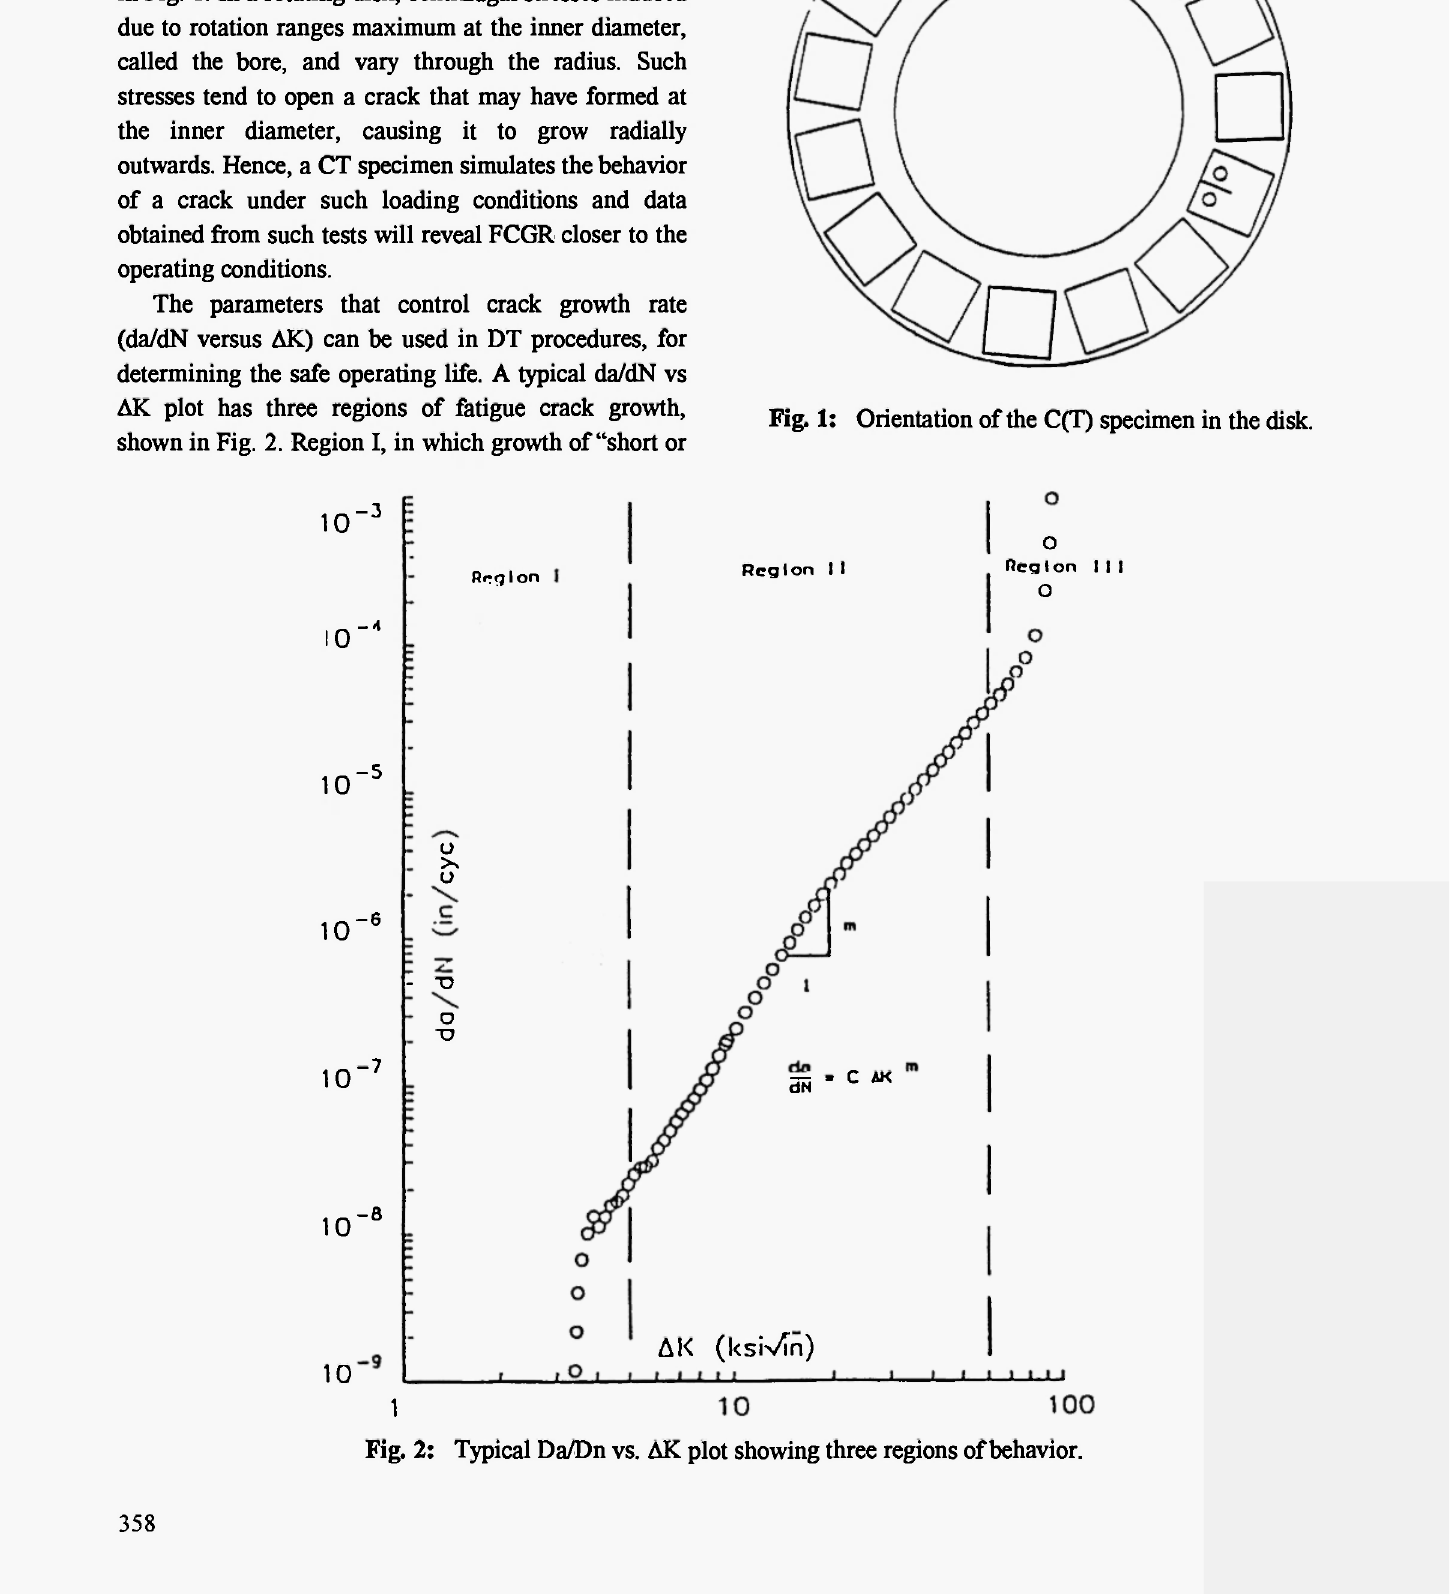
Fig. 2: Typical Da/Dn vs. ΔΚ plot showing three regions of